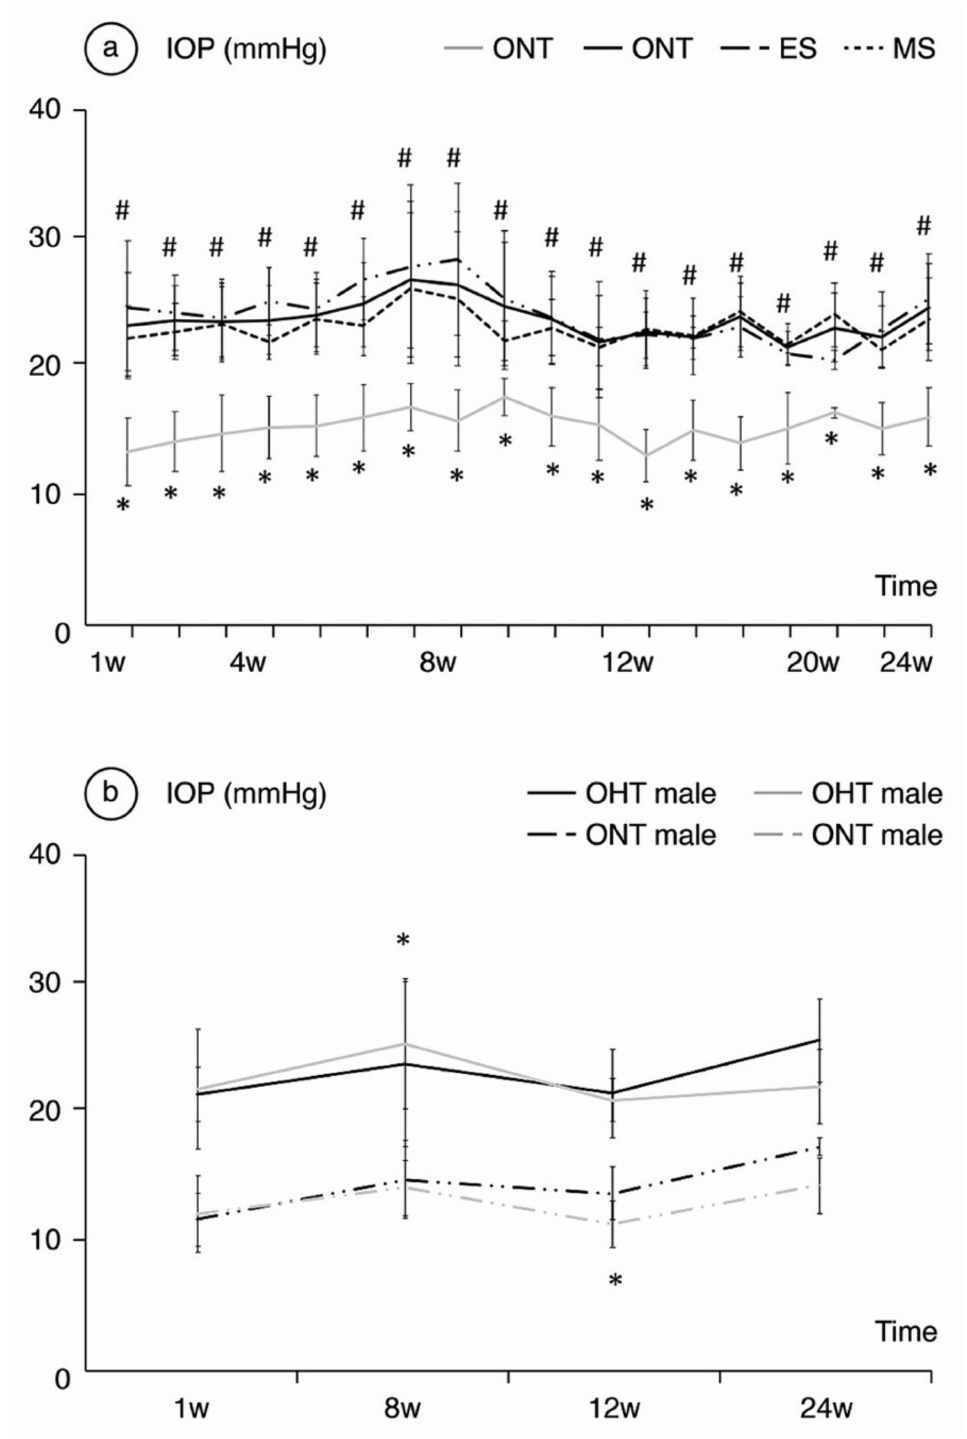
Figure 1. Analysis of intraocular pressure (IOP) in mmHg over the 24-week follow-up comparing the ocular normotension (ONT) and ocular hypertension (OHT) cohorts ( a ) and comparing both sexes ( b ). Abbreviations: w: week; ES: episcleral sclerosis group; MS: microspheres group; * statistical differences between the ONT and the OHT cohorts; #: statistical differences between the ES and MS